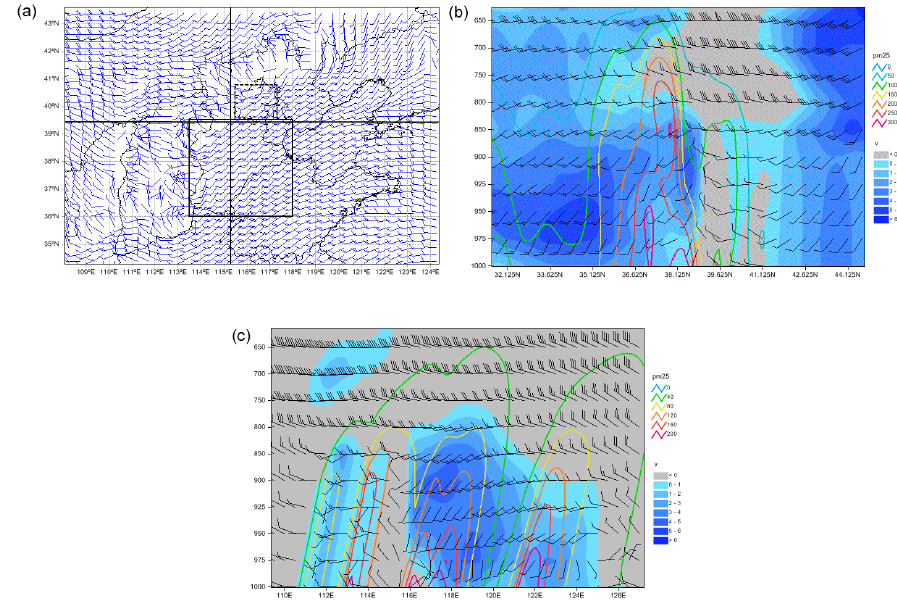
Figure 5. (a) Horizontal wind field at 900hPa, and its vertical section at (b) 115.25 ◦ E and (c) 39.375 ◦ N at 08:00UTC (16:00LT), 7 De- cember 2013.